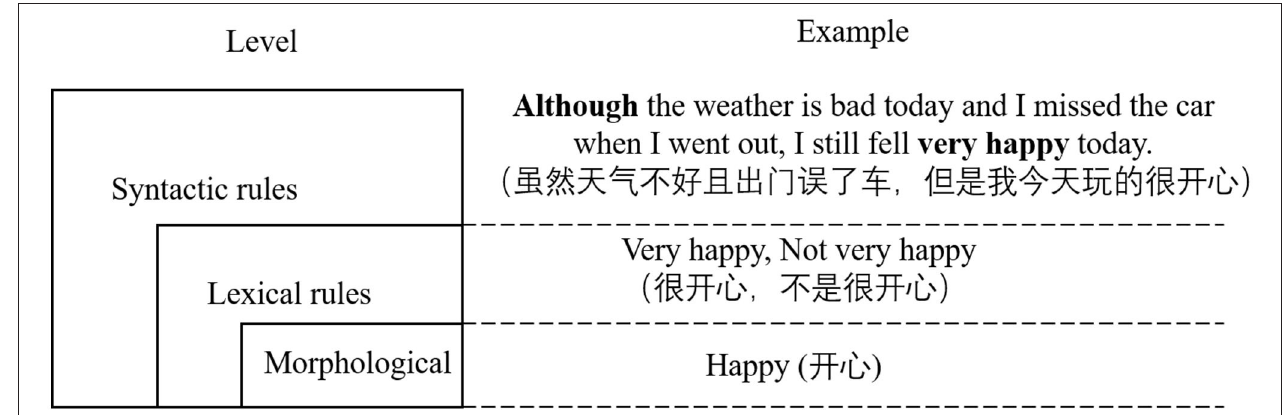
FIGURE 1 | The relation of the three